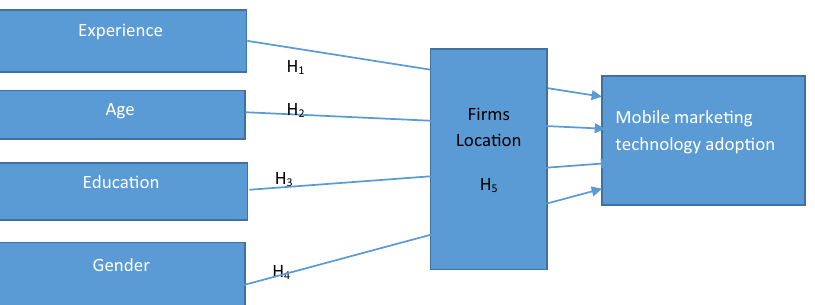
Fig. 1 Analytical framework for the study. This depicts the framework used in investigating the demographic determinants of mobile marketing technology adoption by small and medium enterprises (SMEs) in Ekiti State, Nigeria. The four boxes on the left side show the demographic determinants of mobile marketing technology adoption contexts under which these factors were investigated. They demonstrated the interconnections with three groups of variables. These variables are the independent variables which include experience, age, education, gender, while the dependent variable is the mobile marketing technology adoption. The moderating variable is the fi rm ’ s location. The initial version of the paper was presented at Proceedings of